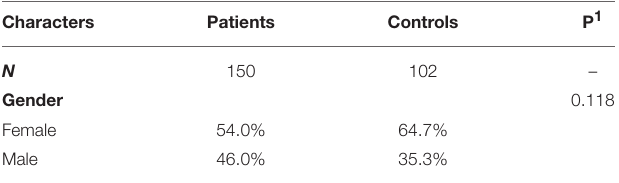
TABLE 2 | Gender characteristic in patients and controls.